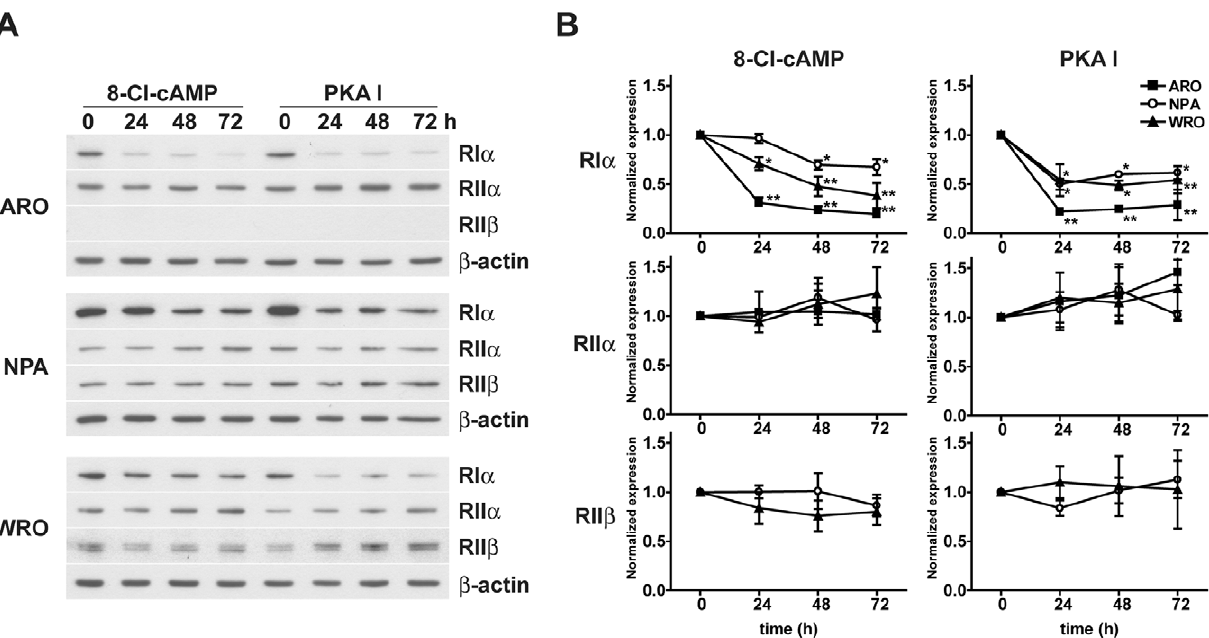
Figure 4. Effect of 8-Cl-cAMP or PKA I-selective cAMP analogs on the levels of PKA regulatory subunits. ARO, NPA and WRO cells were treated with 8-Cl-cAMP (100 m M) or the PKA I-selective cAMP analogs (100 m M each) for the indicated periods of time. The levels of RI a , RII a and RII b were measured by Western blot analysis. Shown are representative Western blots (A) as well as the results of the densitometric analysis of four independent experiments (B). * P , 0.01 vs. basal. ** P , 0.001 vs. basal. These data are expressed as variation versus baseline.